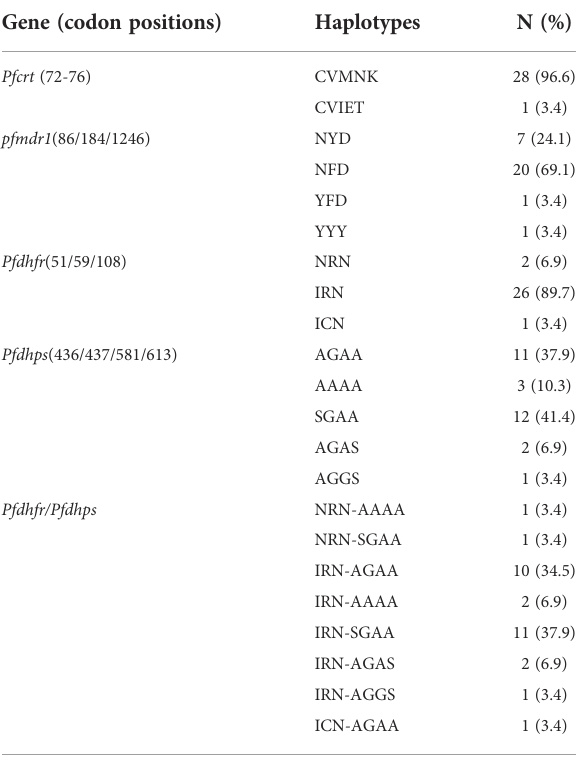
TABLE 3 The prevalence of haplotypes of drug resistance genes.